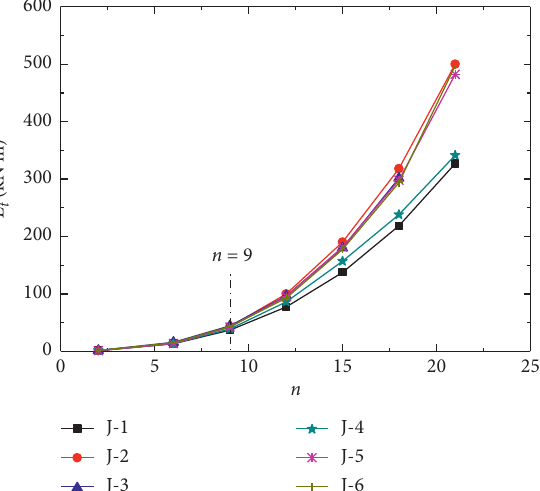
Figure 18: Hysteresis loop.